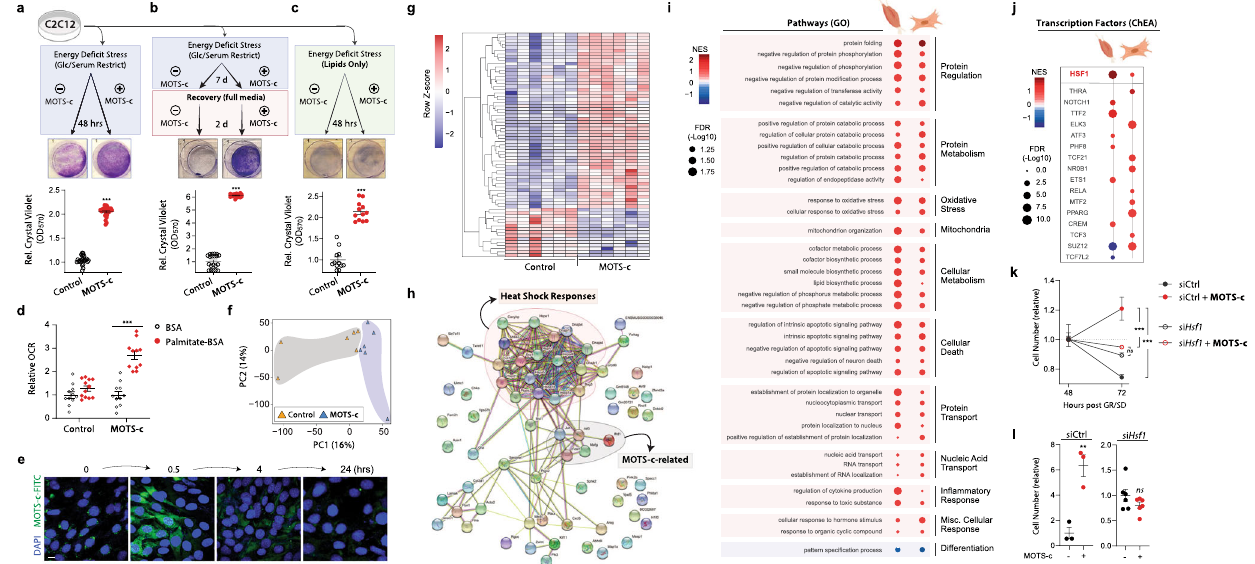
Fig. 5 MOTS-c regulates myoblast gene expression and enhances adaptation to metabolic stress. a – c Survival of MOTS-c-treated (10 µ M; equal-volume vehicle control) C2C12 myoblasts assessed by crystal violet staining following a 48 h of glucose restriction (GR; 0.5 g/L) and serum deprivation (SD; 1% FBS) with MOTS-c treated only once initially ( n = 12, duplicates; P = 2.57E-25), b 7 days of GR/SD with daily MOTS-c treatment, followed by a 2-day recovery in full media with MOTS-c ( n = 10, duplicates; P = 8.95E-22), and c 48 h of complete GR (0 g/L) with chemically de fi ned lipid supplementation